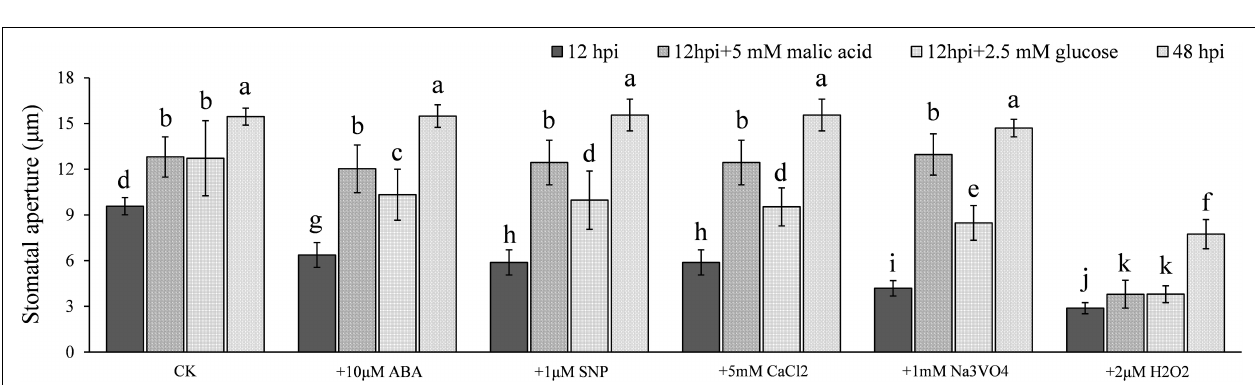
FIGURE 5 | Glucose and malate accumulations were responsible for the full stomatal opening during P. infestans infection. Stomatal apertures reached the maximum 48 hpi and failed to the stimulation by ABA, NO, CaCl 2 , and Na 3 VO 4 . Glucose and malate supplement to epidermal strips collected 12 hpi showed a similar trend. Photos within a panel are from a representative of a single replicate while photos among panels are pooled from multiple